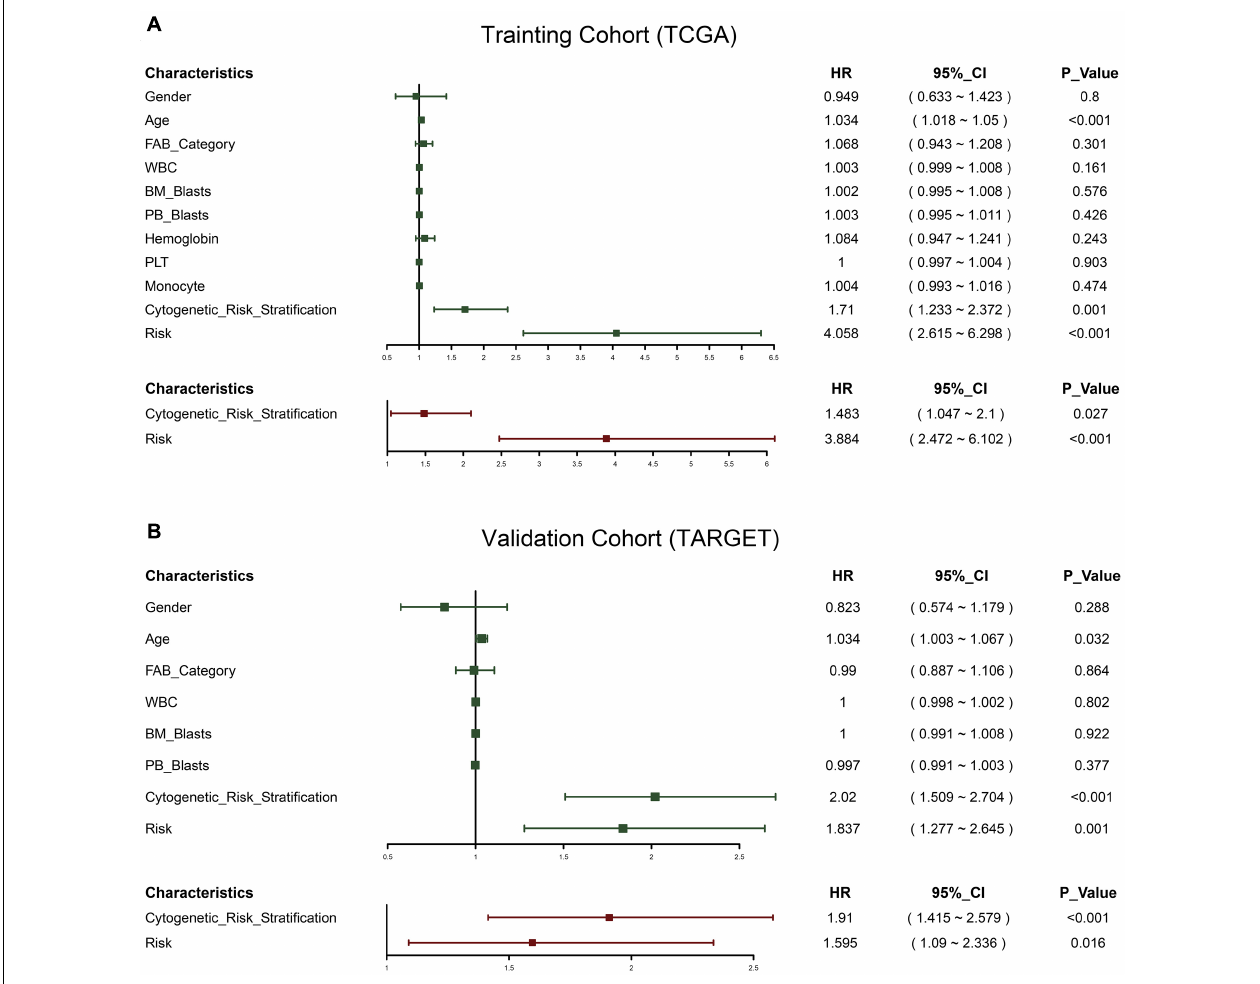
FIGURE 3 | Forest plot of the univariate and multivariate Cox regression analysis in acute myeloid leukemia (AML). Green represents univariate Cox, and red represents multivariate Cox. TCGA cohort (A) ; TARGET cohort (B)